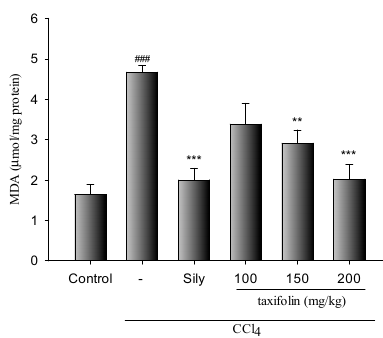
Figure 3. Taxifolin and Sily effects on hepatic MDA levels in mice with hepatic injury induced by CCl 4 ; data are presented as means ± SEM ( n = 10). ### p < 0.001, compared with the control group; *** p < 0.001, compared with the CCl 4 only group; ** p < 0.05, compared with the CCl 4 -only group; One-way